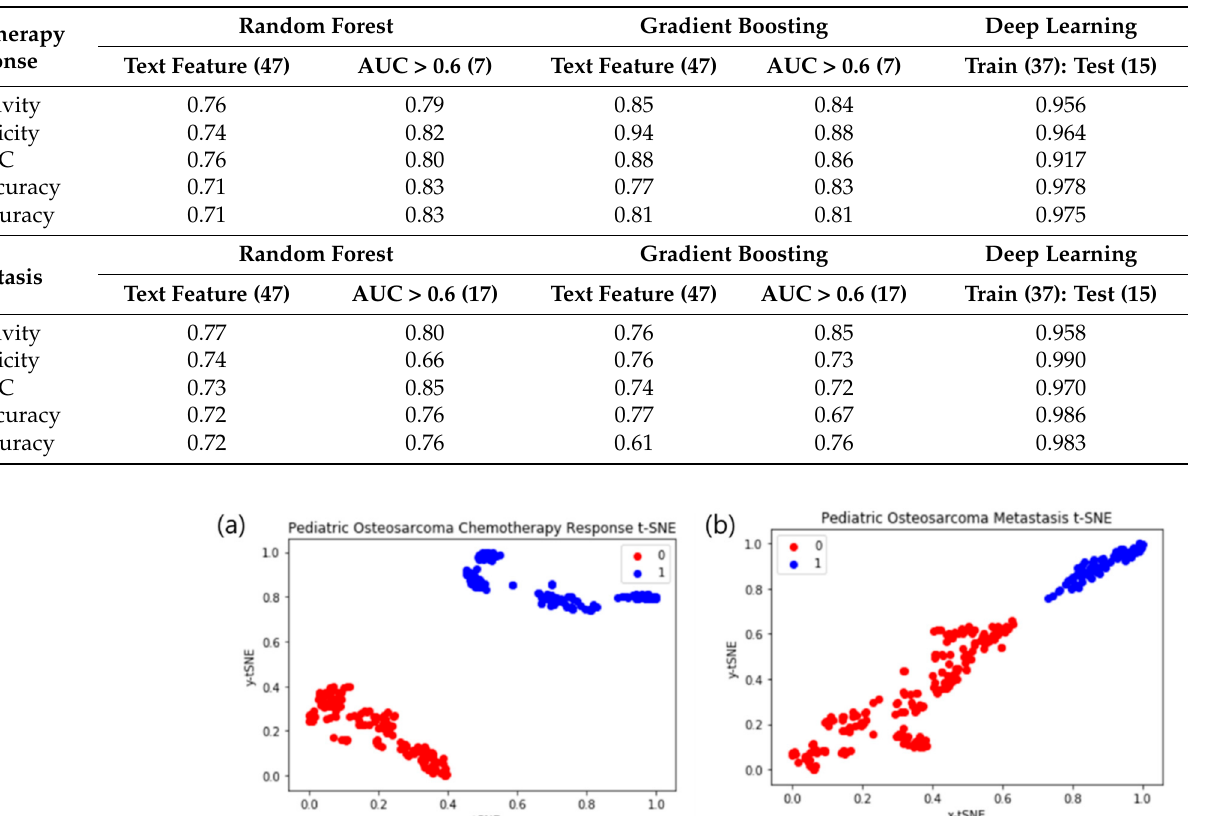
Table 2. Chemotherapy response and metastasis prediction model with various machine learning algorithms and deep learning.